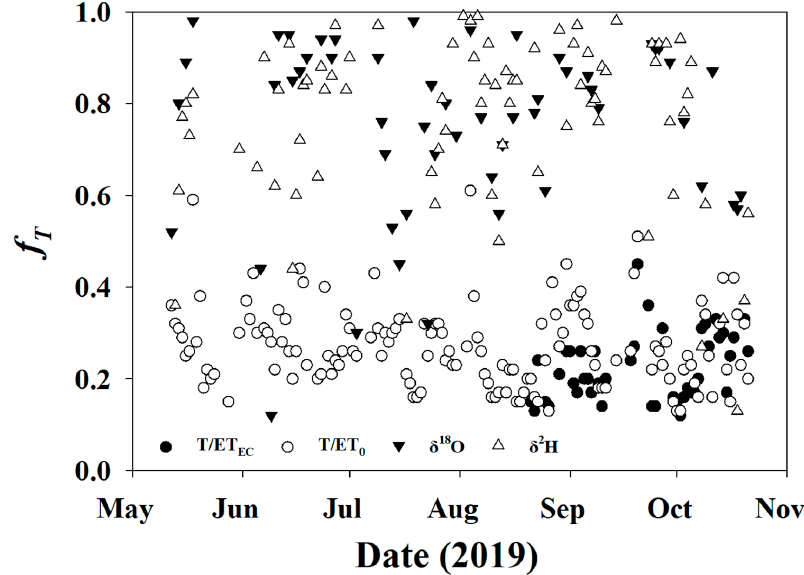
Figure 10. Fractional transpiration computed using T / ET EC (closed circles), T / ET 0 (open circles) δ 2 H (open triangles), and δ 18 O (closed triangles).